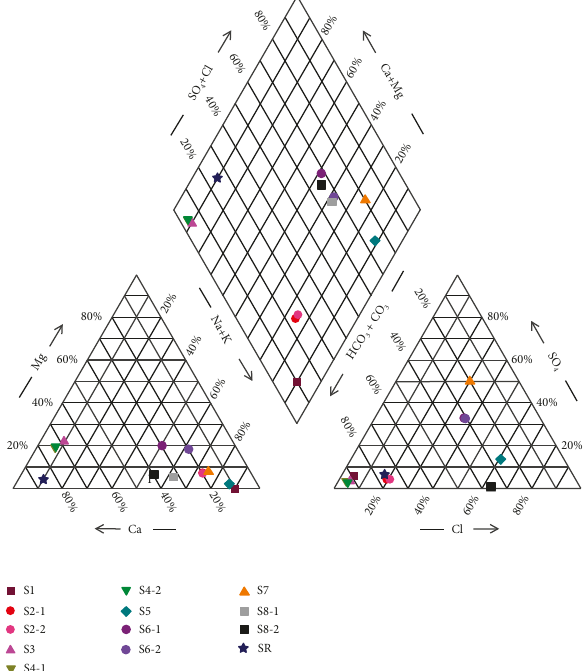
Figure 2: Piper diagram showing the hot spring water samples in the Simao